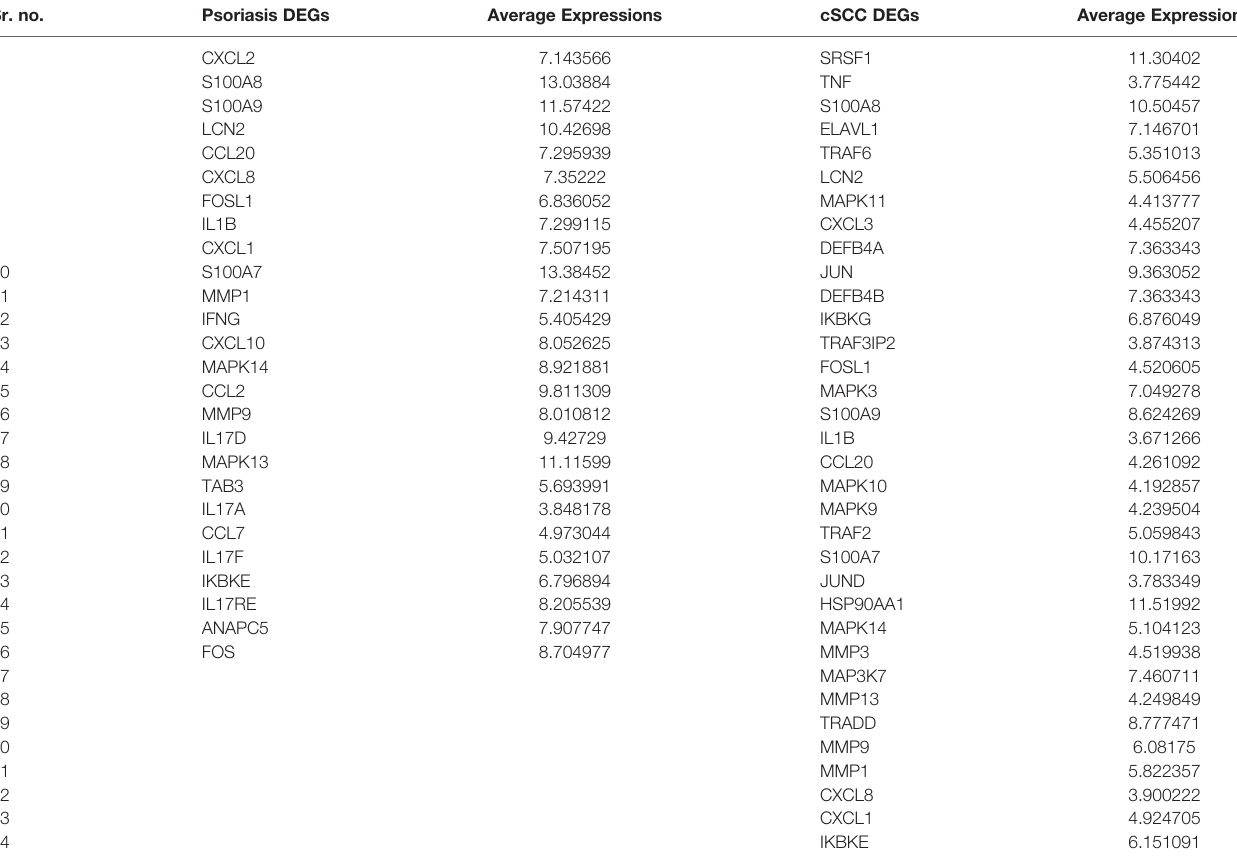
TABLE 5 | DEGs of psoriasis and cSCC signi fi cantly enriched in IL-17 signaling pathway. Sr.